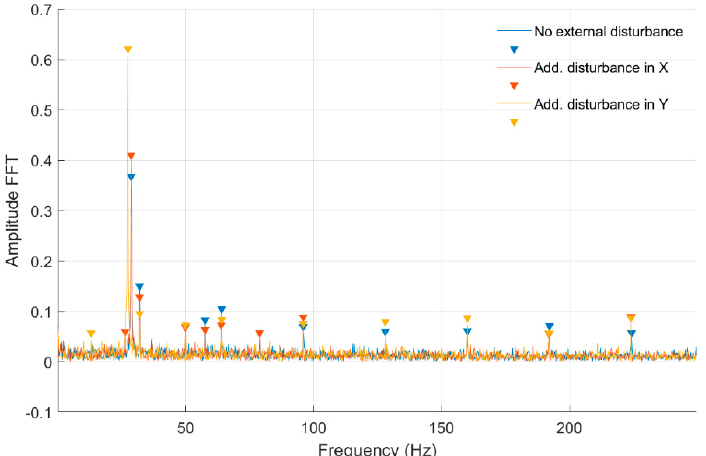
Figure 13. FFT of strain-level measurement for constant motor speed equal to 30 rev / s with disturbance from the control system for a quarter-bridge configuration (Node 955).